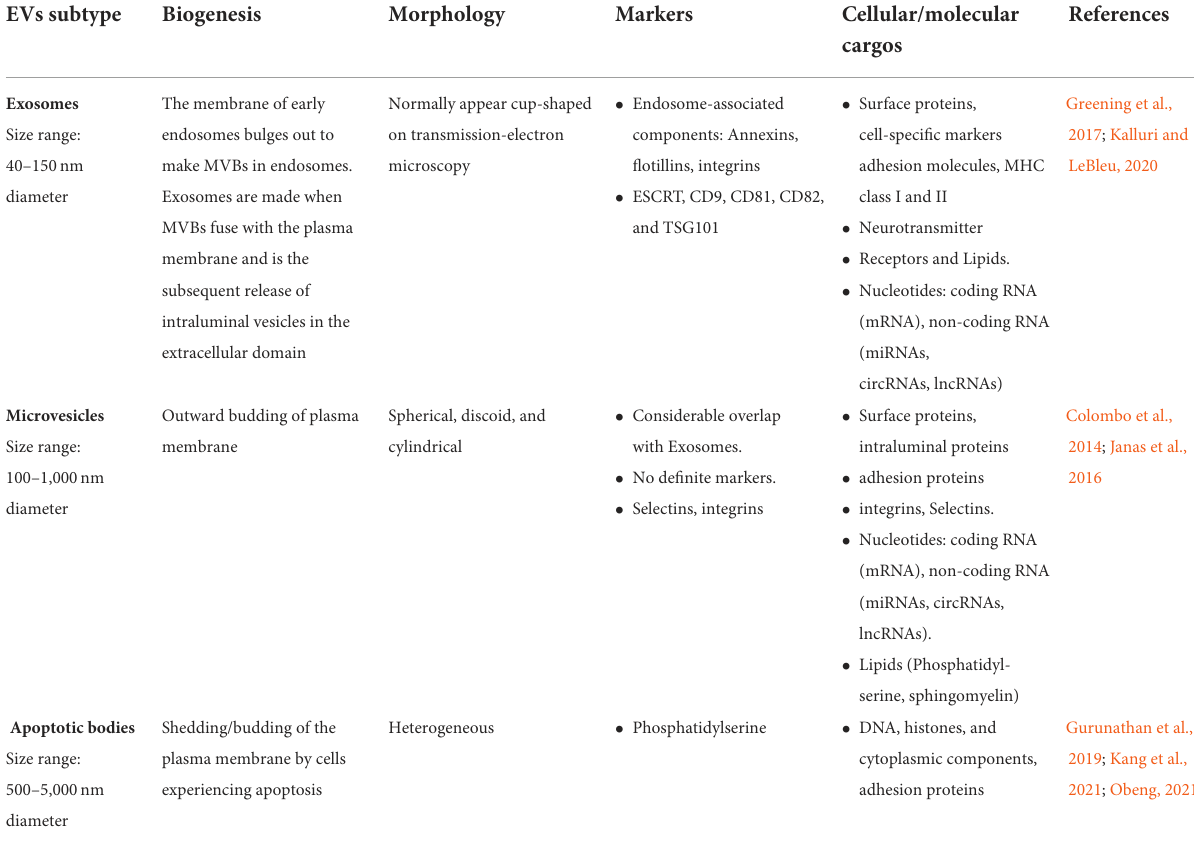
TABLE 1 Characteristics of extracellular vehicles (EVs)